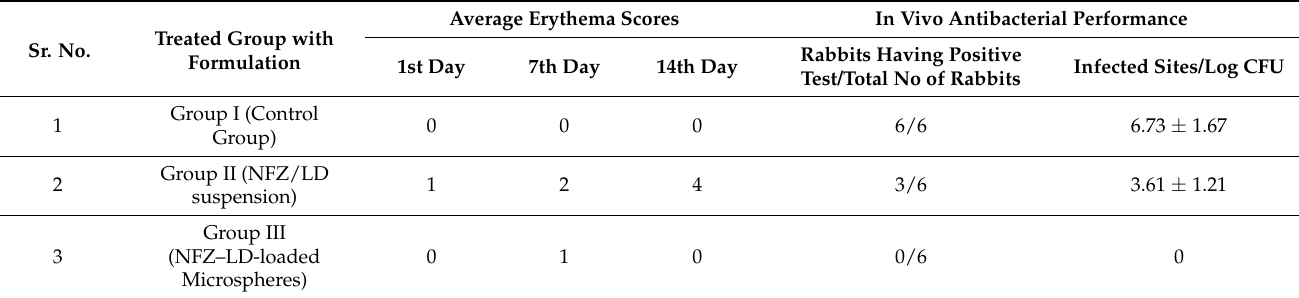
Table 4. Average erythema score for formulations and comparative in vivo antibacterial results.